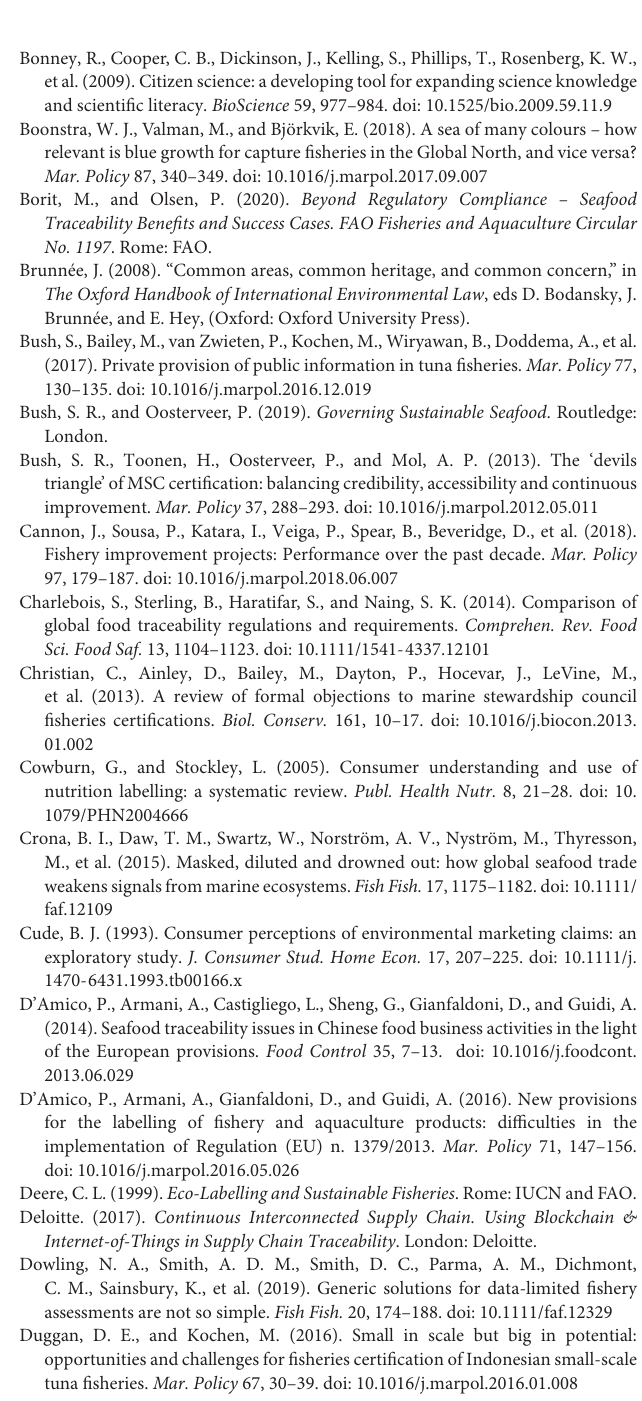
Supplementary Figure 3 | A possibility for enhanced mandatory labeling for